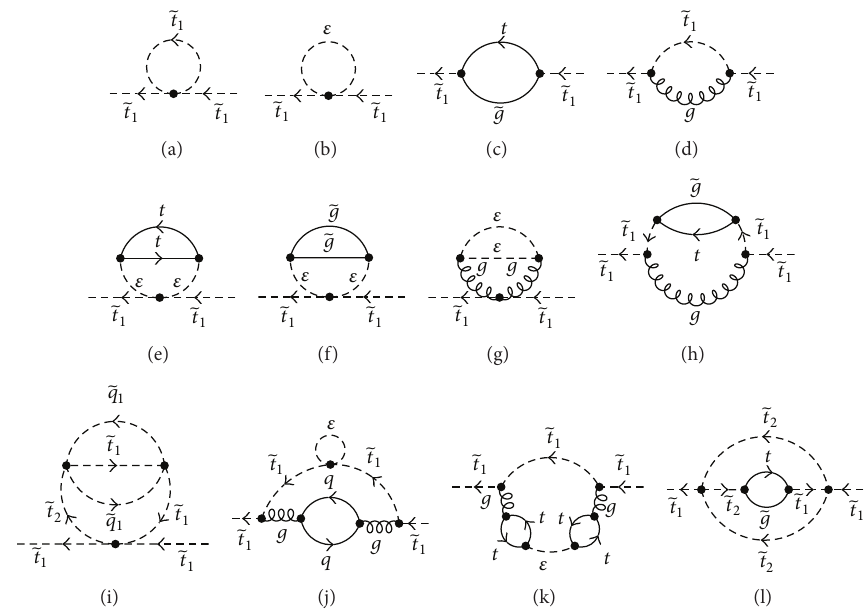
Figure 3: Sample diagrams contributing to Σ 11 at one, two, and three loops. The symbols 𝑡 , ̃𝑡 𝑖 , 𝑔 , ̃𝑔, and 𝜖 denote top quarks, top squarks, gluons, gluinos, and 𝜖 -scalars,